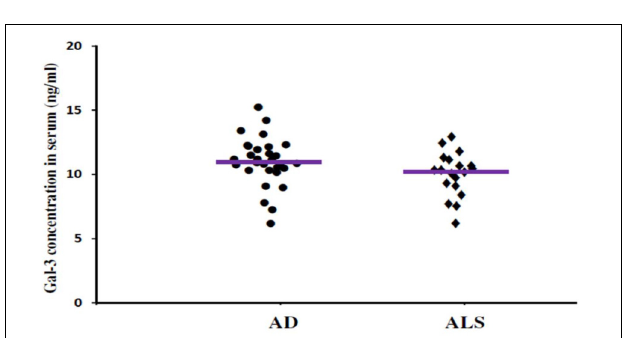
FIGURE 4 | The concentrations of Gal-3 in serum (ng/mL) of AD and ALS. There was no significant difference in the concentrations of Gal-3 in serum of AD and ALS patients (AD vs. ALS [mean ± SD] 11.19 ± 3.67 vs. 10.45 ± 3.48 ng/mL; P =